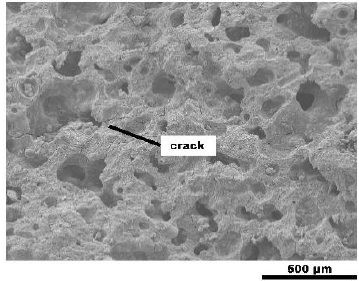
Figure 8. Scanning electron microscope (SEM) images of the obtained geopolymeric foam.